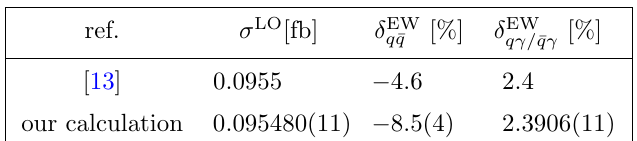
Table 2. Comparison of the LO cross section (cid:27) LO and relative NLO EW corrections (cid:14) EW the process pp ! e (cid:0) (cid:22) (cid:23) e (cid:22) + (cid:23) (cid:22) (cid:22) + (cid:23) (cid:22) + X with parameters and de(cid:12)nitions as given by ref. [13]. Monte Carlo integration errors are indicated in parentheses after each result.